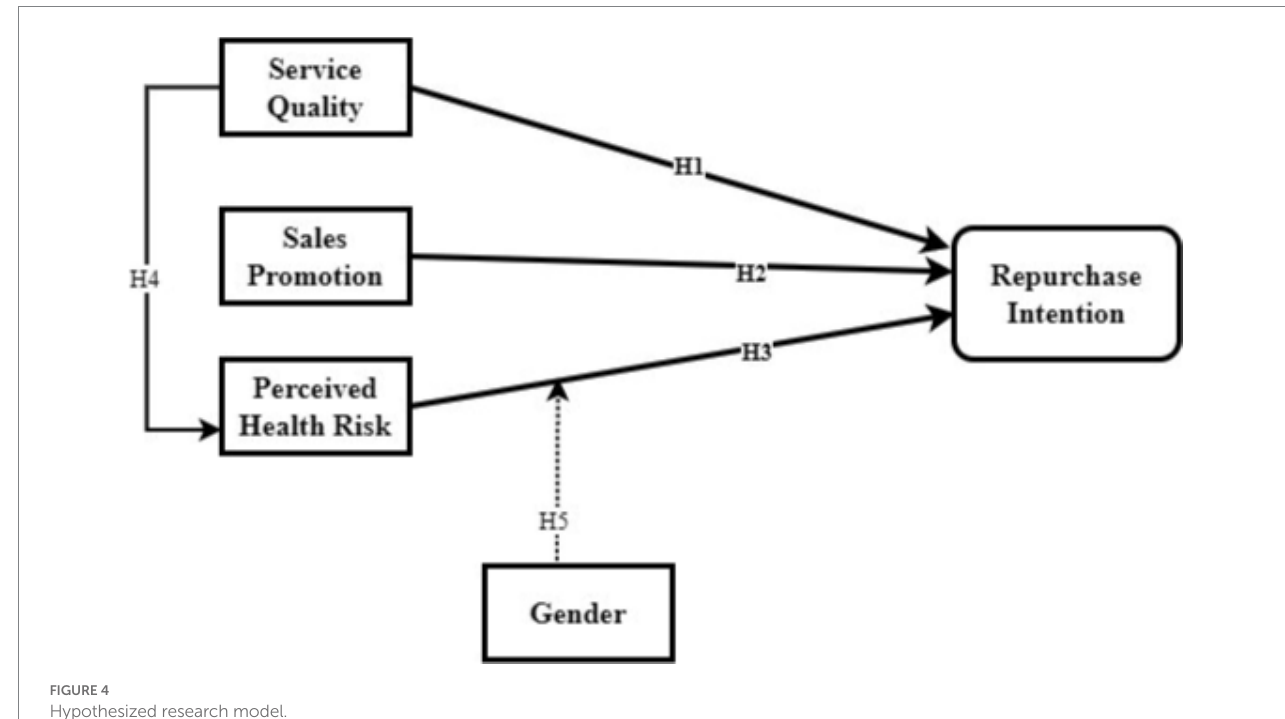
FIGURE 4 Hypothesized research